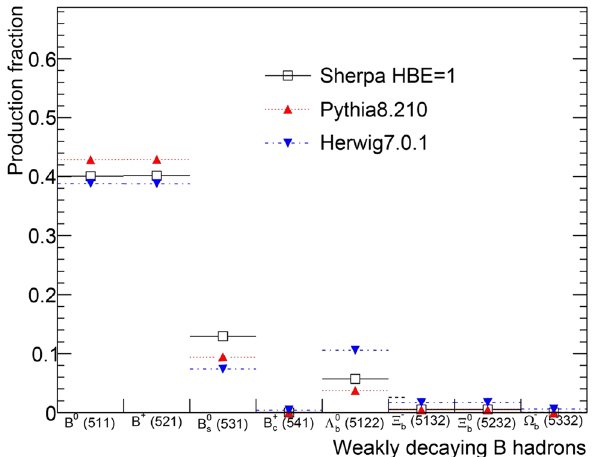
Fig. 3 b -hadron production fractions at LHC extracted from several physics generators: Sherpa [47], Pythia [48] and Herdwig [49]. In the case of Sherpa HBE = 1 the Heavy Baryon Enhancement parameter (HBE) is set to one to improve the modelling of heavy quark hadroniza- tion fragmentation fraction of a b quark hadronizing into a Λ b − → Ξ − J /ψ and Λ → Λ J /ψ decay ( f Λ ), using the Ξ b b b modes